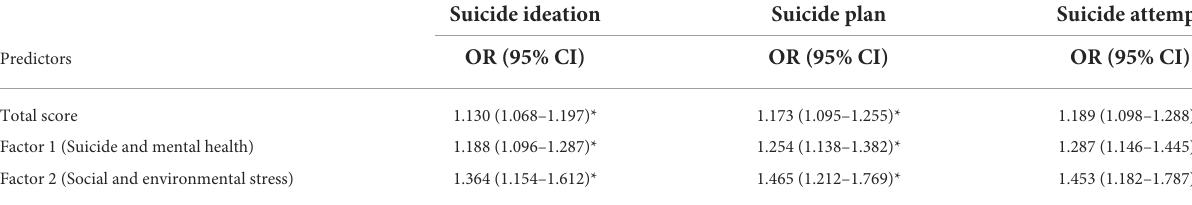
TABLE 4 Logistic regression models of the relationship between SSQ-OR and Suicide Ideation, suicide plan, or suicide attempt during 6 months follow-up ( n = 157).